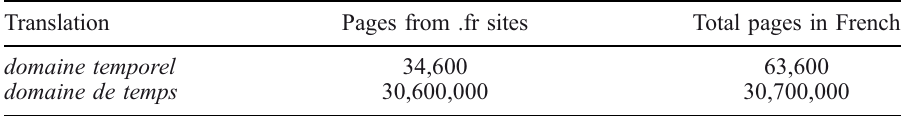
Table 1. Online frequencies for alternative French translations of ‘ time domain ’